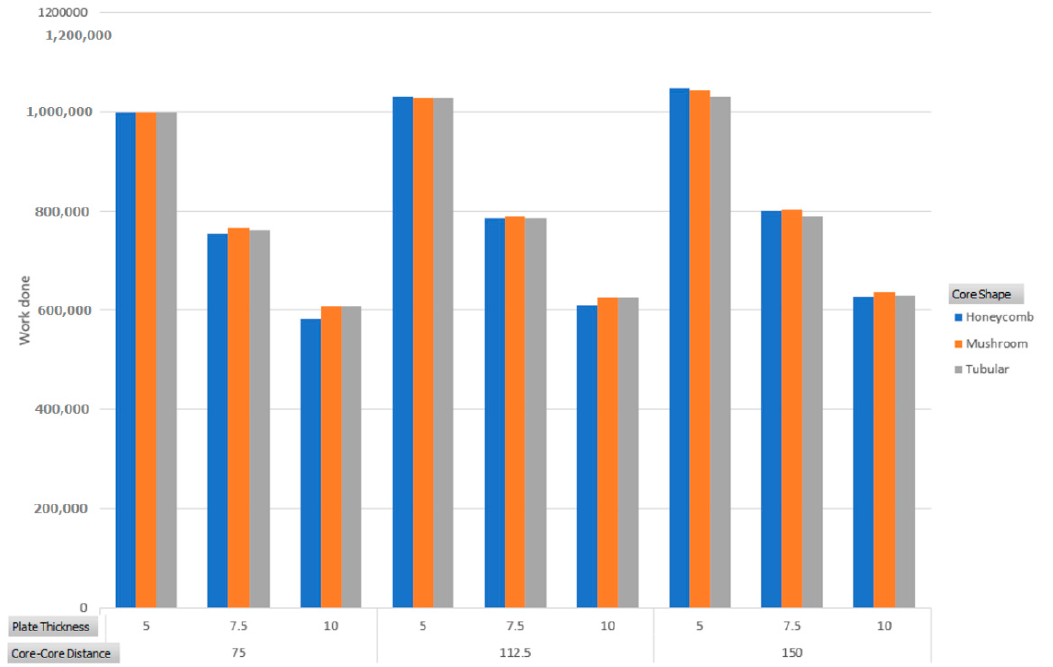
Figure 12. Work of external forces categorized by core shape, plate thickness, and core–core spacing.